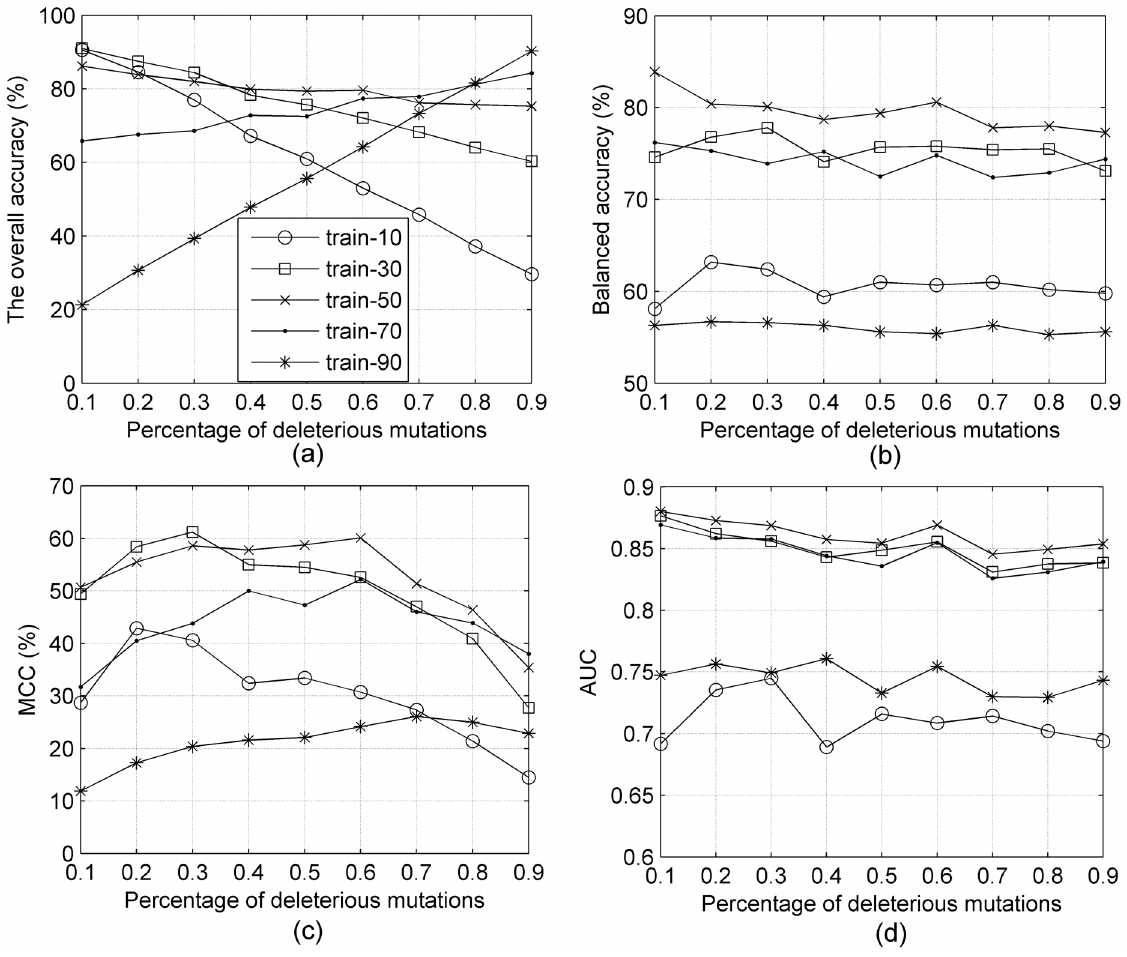
Figure 4. (a) ACC, (b) BACC, (c) MCC, and (d) AUC of five SVM models trained on 5 different data sets (train_10, train_30, train_50, train_70, and train_90) tested by 9 different testing data sets, ranging from 10% deleterious (x-axis=0.1) to 90% deleterious (x- axis=0.9).